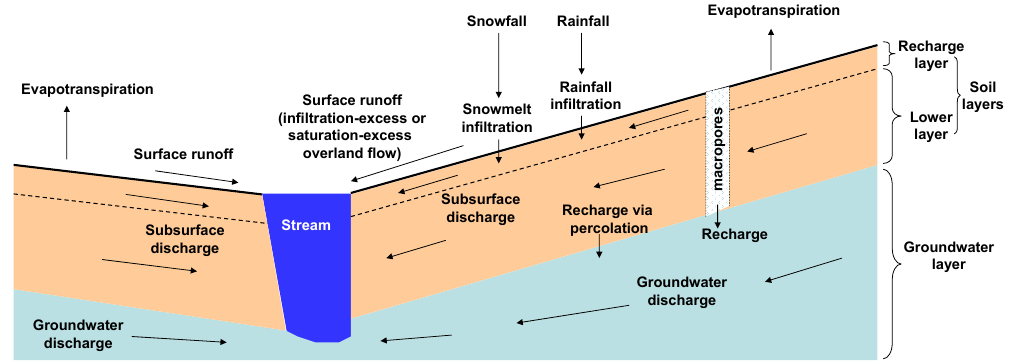
Fig. 3. Conceptual representation of CRHM’s hillslope module with control volumes of two soil layers, groundwater layer, and surface depressions or macropores and their interactions. Note that saturated porous media flow always occurs in the groundwater layer and can episodically occur in the soil